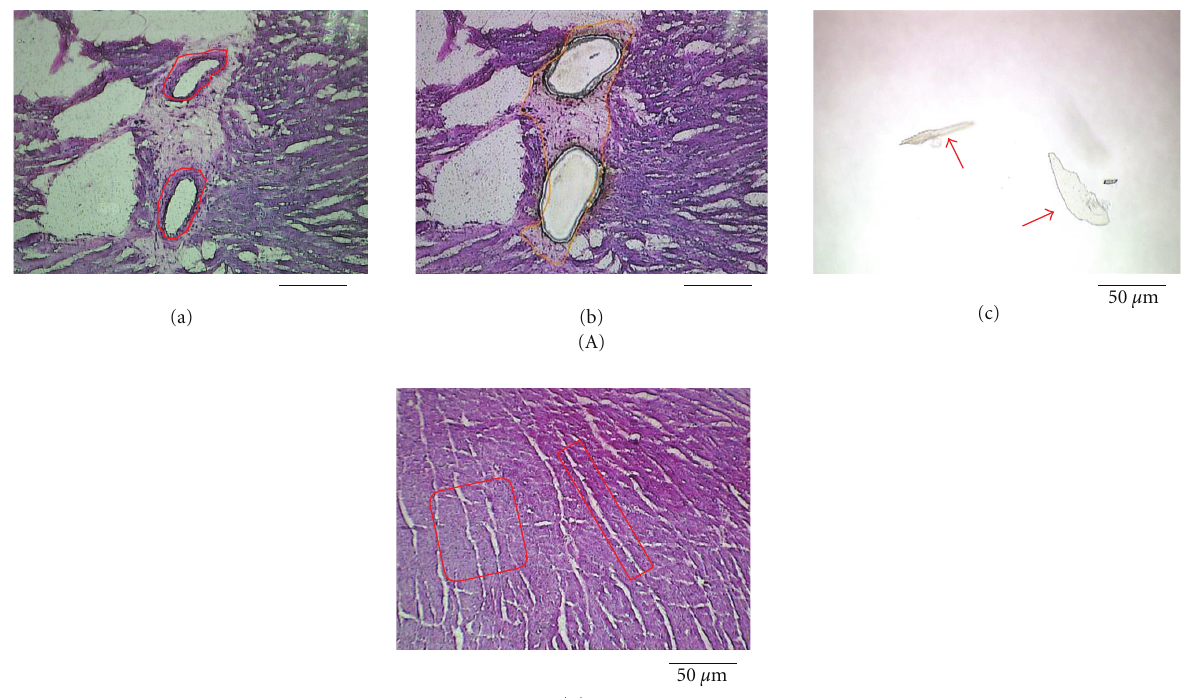
Figure 1: (A) Representative microphotographs demonstrating the sampling of vascular area of the myocardial section obtained from SHR- SP using LMD method. (a) Laser cut lines (red lines) were placed on the outside border of the medial smooth muscle layer. (b) Myocardial section after vascular samples were cut o ff by laser dissection shown. (c) After laser dissection, isolated vascular fragments (red arrows) fell down into the caps of Eppendorf tubes containing TRIzol reagent. The vascular fragments were being lysed in the TRIzol reagent. (B) For sampling myocardial area, laser cut lines were placed not to include microscopically visible vasculatures and infiltrating cells in the area of